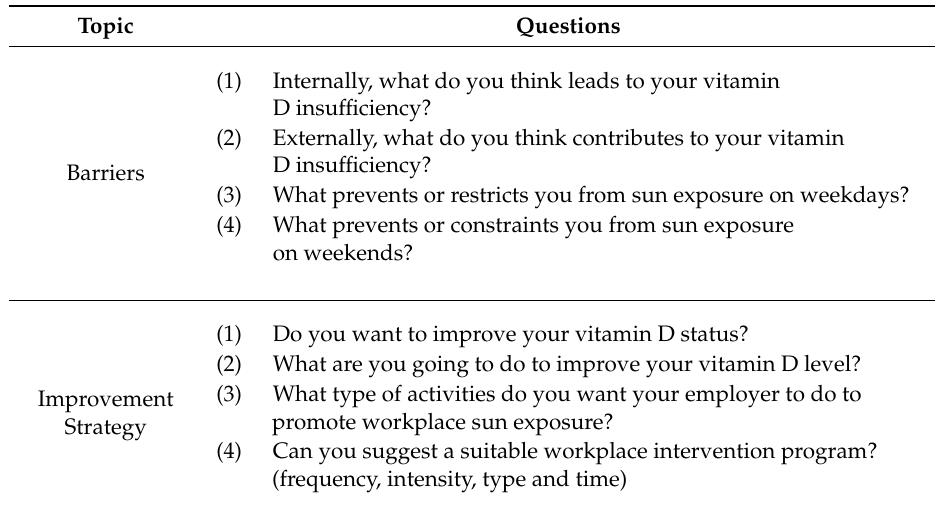
Table 1. Focus Group Discussion